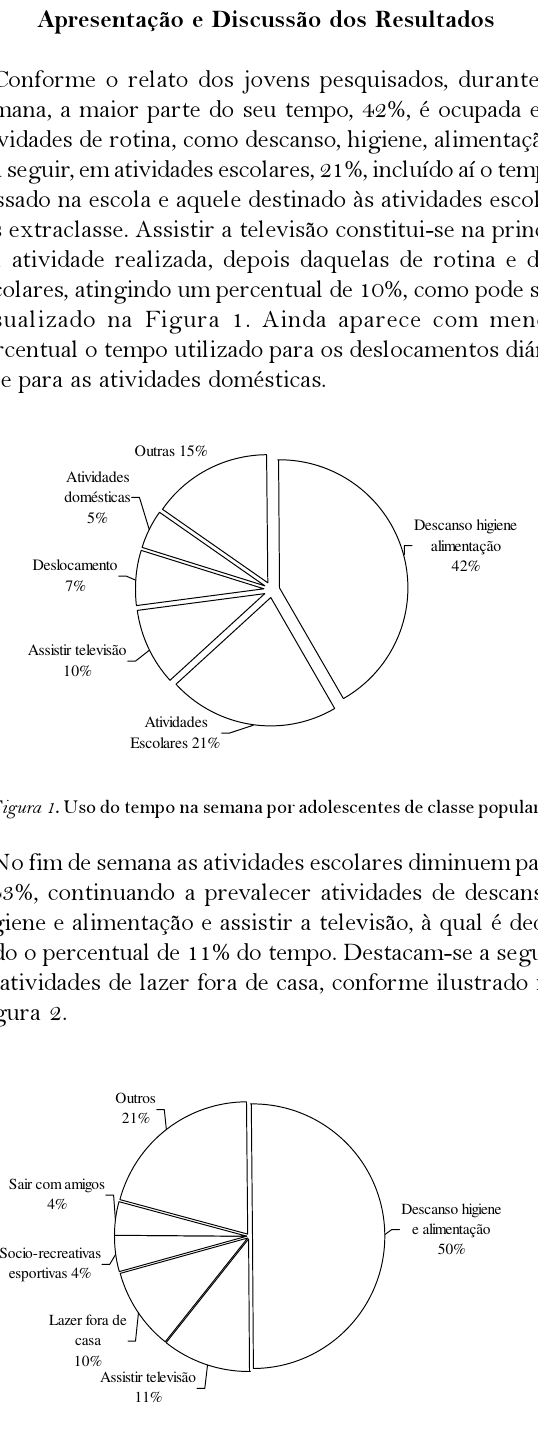
Figura 2. Uso do tempo no fim de semana por adolescentes de classe popular. Tanto durante a semana como no fim de semana, obser- va-se pouca freqüência de atividades culturais, artísticas, socio-recreativas e esportivas às quais é dedicado entre 3,42% a 4,0% do tempo. Chama a atenção a pouca freqüên- cia de atividades relacionadas ao uso do computador, as quais ocupam entre 1,48% a 2,63% do tempo, o que pode ser associado ao baixo percentual dos jovens que possuem computador em